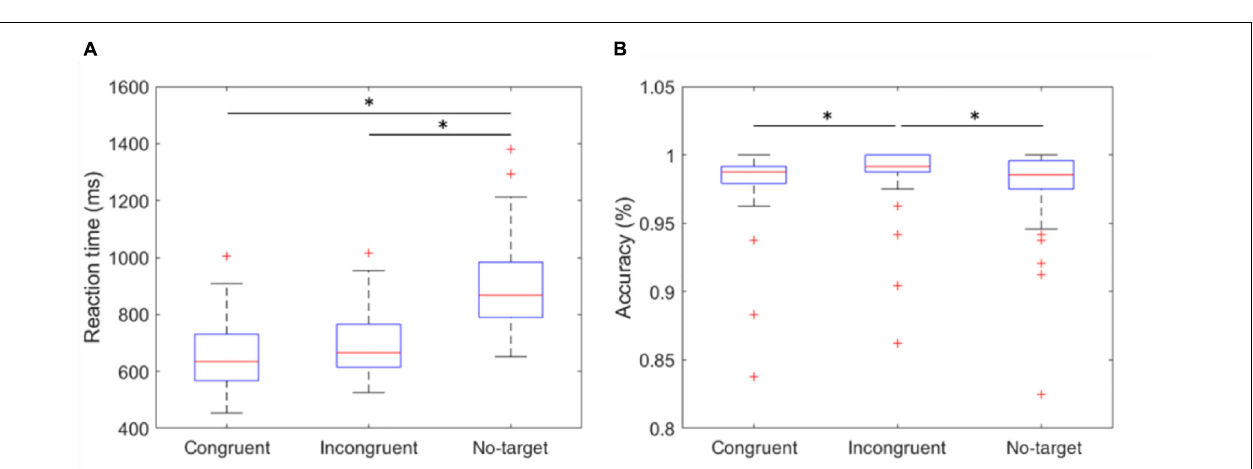
FIGURE 4 | Reaction time and accuracy of congruent, incongruent, and no-target stimulus. (A) The mean RT of the three conditions. The RT of no-target stimulus was significantly longer than other conditions. (B) The accuracy of the three conditions. The incongruent stimulus induced the highest accuracy of 99.17%